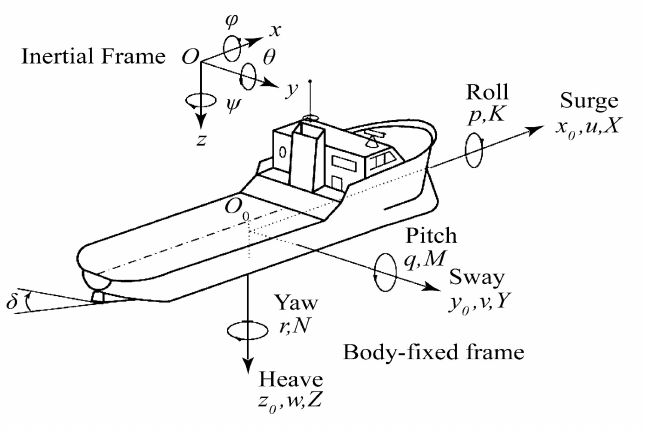
Figure 1. Ship motion